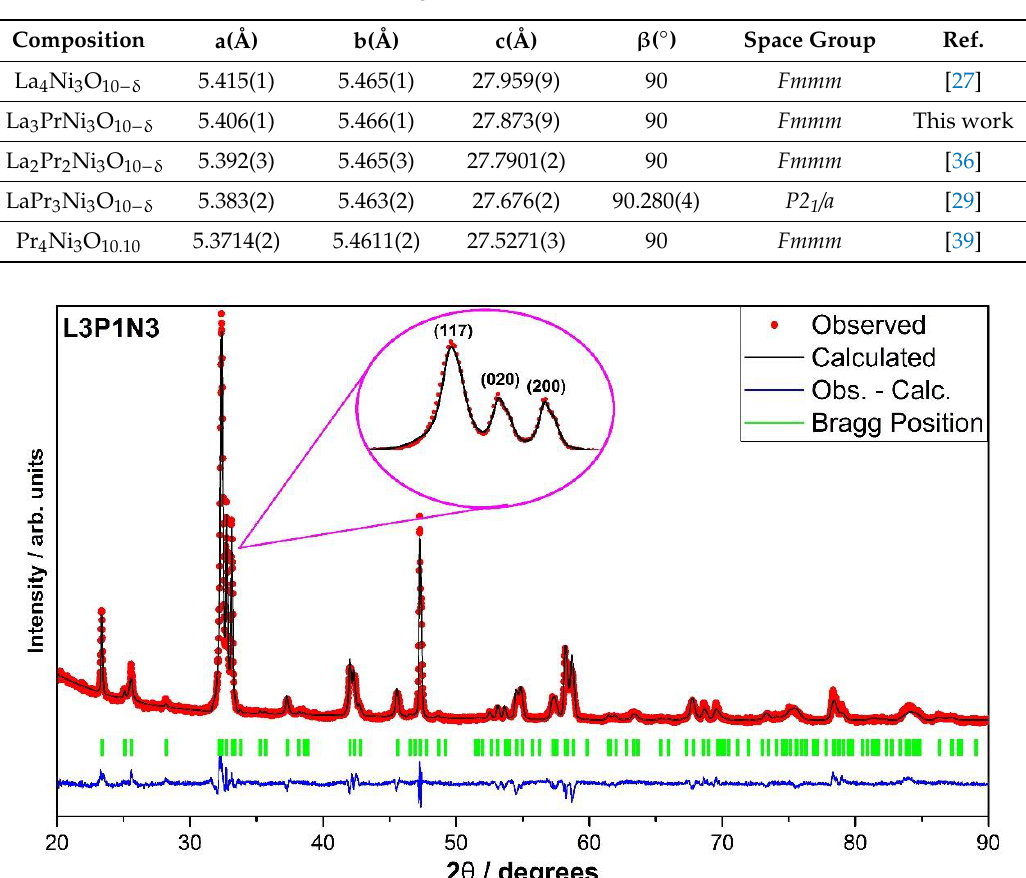
Figure 1. Rietveld refinement of the X-ray diffraction pattern of La 3 PrNi 3 O 9.76 using the orthorhombic Fmmm space group ( χ 2 = 4.2, R p 4.6%, R wp = 6.5%).